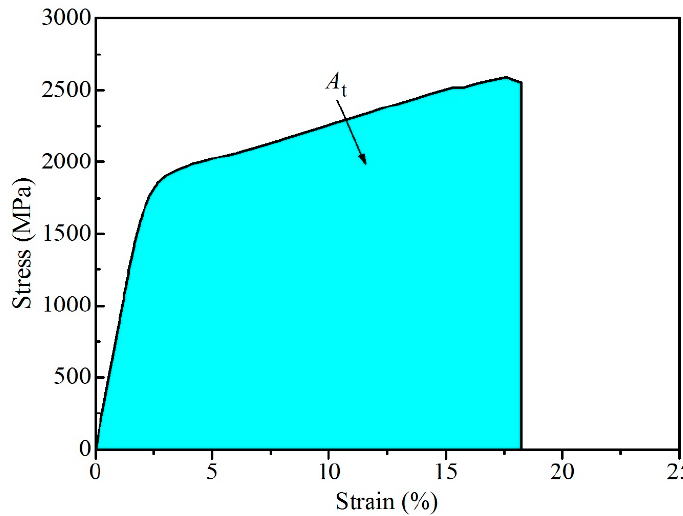
Figure 8. The toughness ( A t ) of the Ti 75 Fe 19 Sn 5 Mo 1 alloy.